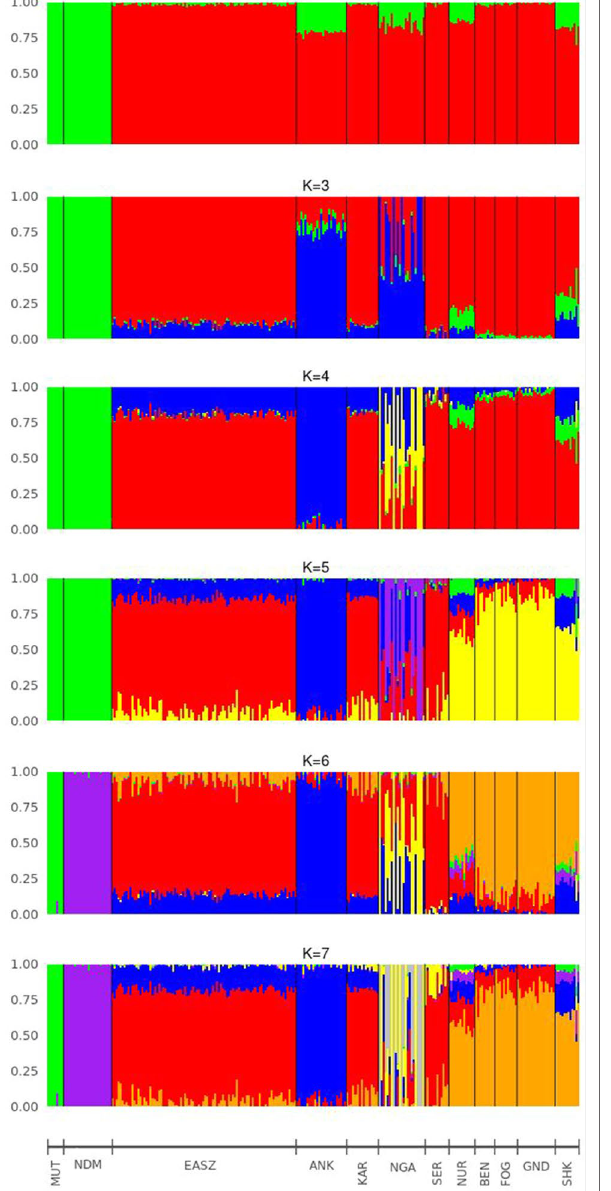
Frontiers in Genetics |